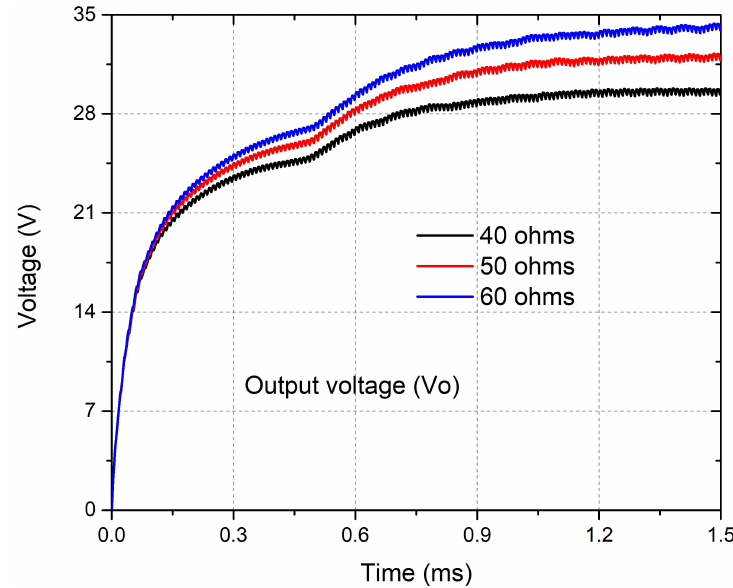
Figure 16. Output voltage plot obtained using P&O